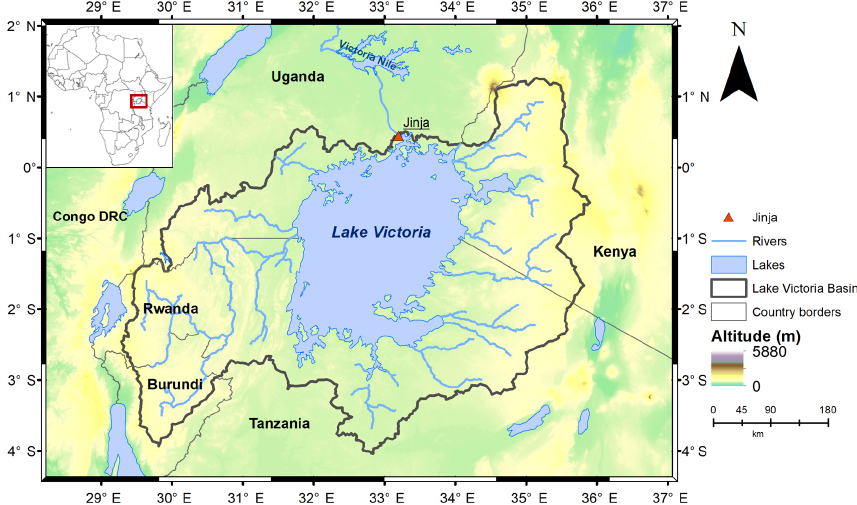
Figure 1. Map of Lake Victoria and its basin with surface heights from the Shuttle Radar Topography Mission